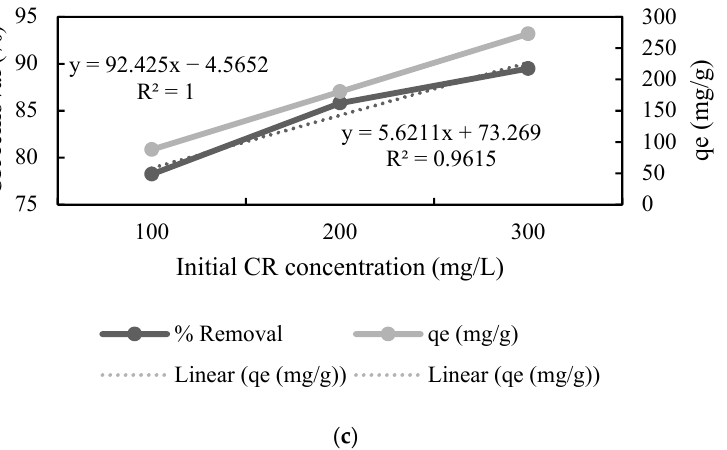
Figure 3. Effect of initial congo red (CR) concentration on adsorption by ( a ) untreated, ( b ) pretreated, and ( c ) fermented sugarcane bagasse ( q e stands for adsorption capacity).